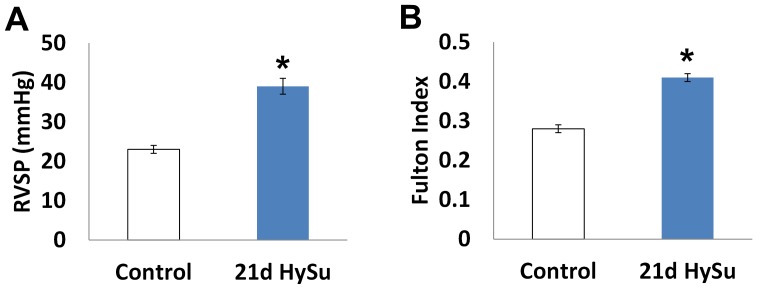
Right ventricular systolic pressure (RVSP) and Fulton index (RV/(LV+S)) measured from control and 21d HySu groups.N  =  5–9 per group. Means ± Standard Errors. * p<0.05 vs. control.